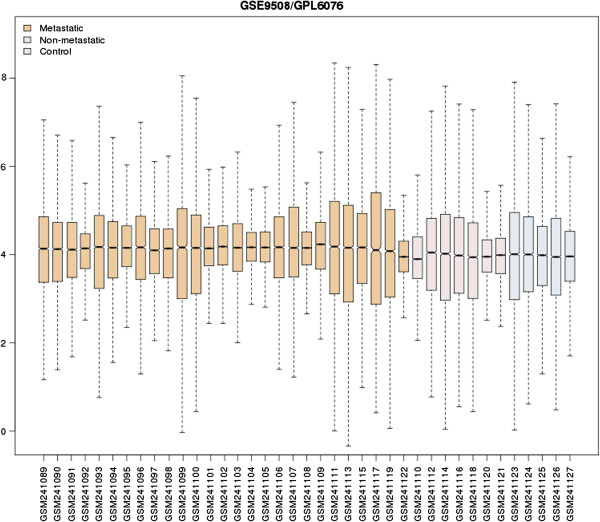
Normalization of gene expressions in metastatic, non-metastatic and control samples. The medians (black lines) are almost at the same level, indicating a good level of standardization.